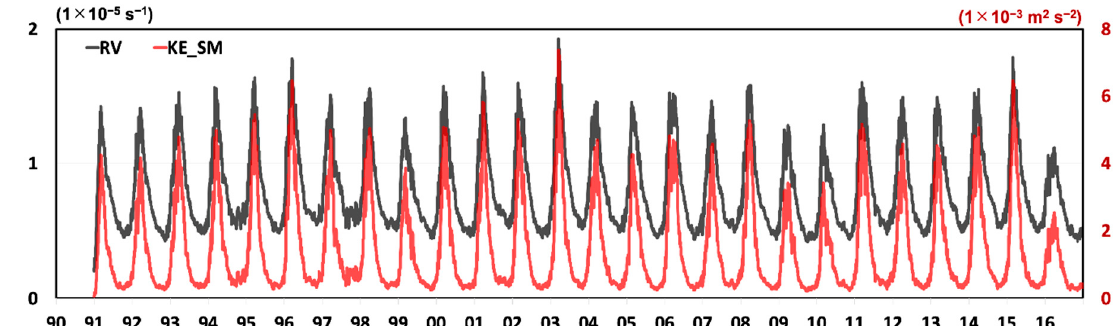
Figure 4. Daily mean time series of surface relative vorticity RMS (black curve) and submesoscale KE (KE_SM, red curve) corresponding to surface kinetic energy with the scales smaller than 100 km in the STCC region. The left and right vertical axes show the scales of relative vorticity RMS and KE_SM respectively.